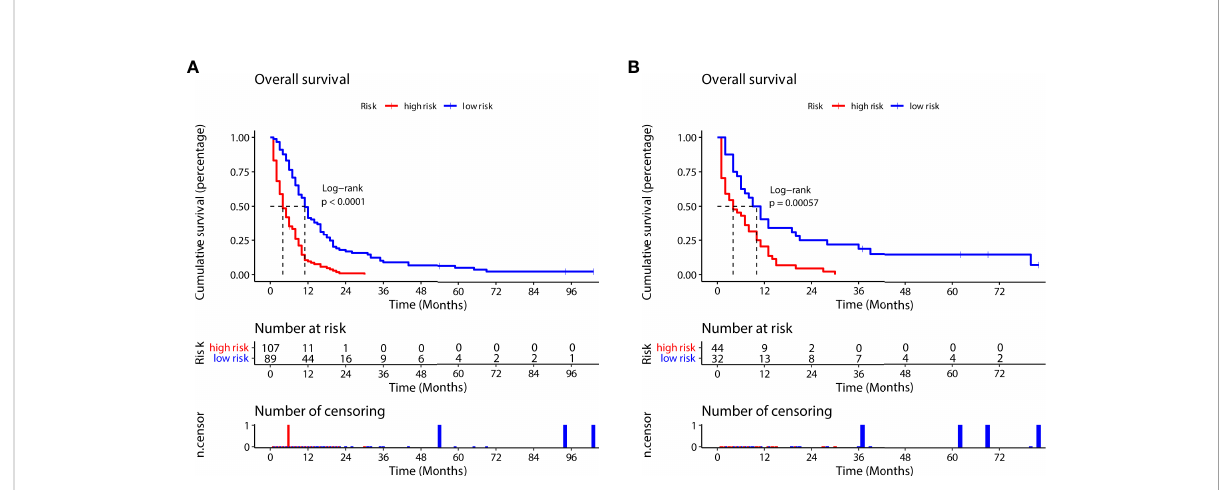
FIGURE 8 Survival outcomes in the training group (A) and validation group (B) for the high-risk and low-risk groups (according to the prognostic nomogram